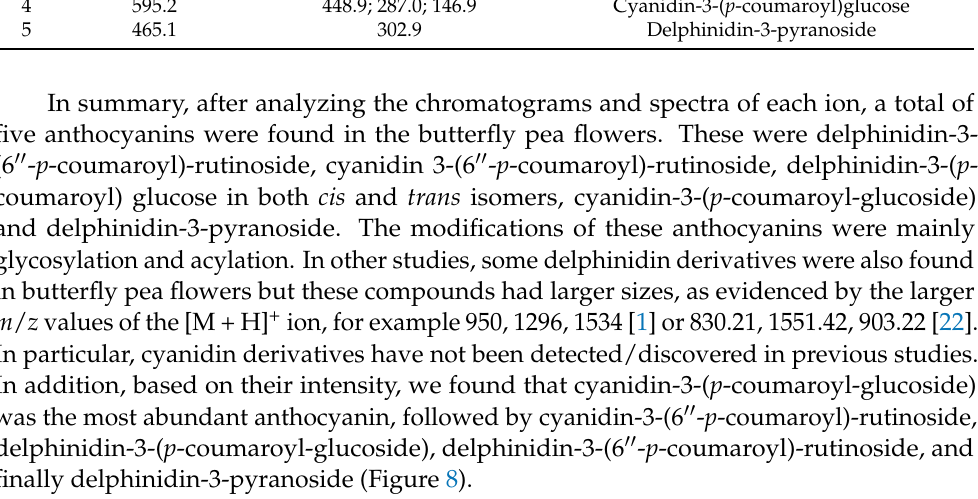
Figure 7. The ion chromatograms ( a ) and ion spectra ( b ) and MS/MS fragments (**) of parent mass 465.2 ( c ).